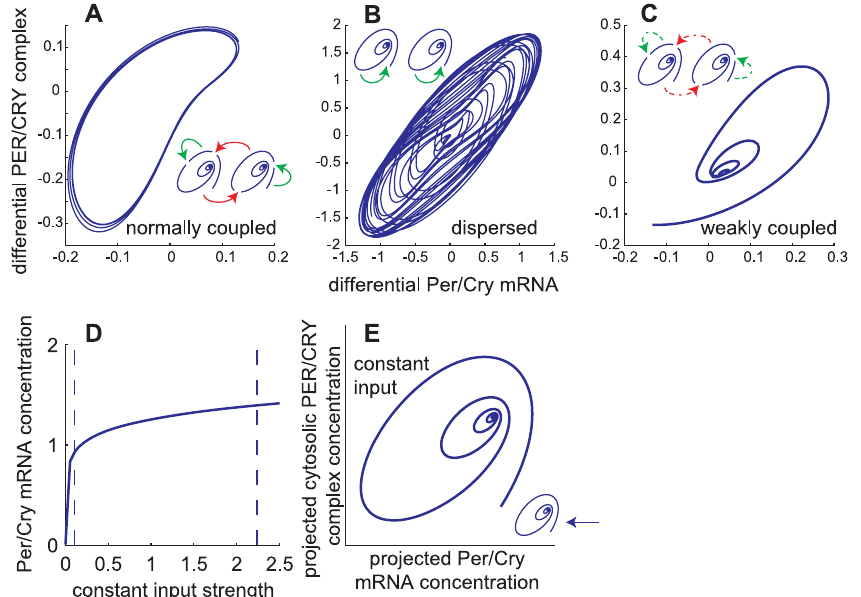
Figure 4. Single-Cell Rhythmicity Implies Synchrony (A–C) Phase space of a network of two oscillators showing possible dynamic behaviors. Each panel represents a condition that was simulated in the previous subsection. The inlets show what kind of coupling was considered (spirals, damped oscillators; solid arrows, normal coupling [ K ¼ 0.9]; dashed arrows, weak coupling [ K ¼ 0.3]; red and green arrows, paracrine and autocrine coupling, respectively). The axes show the differences of Per/Cry mRNA and PER/CRY complex concentrations between the two oscillators. This way, two oscillators can be represented in a 2-D space. (A) Normal, wild-type condition. The oscillators are normally coupled (autocrine and paracrine coupling), and the result is a regular, clock-like cycle denoting synchrony. (B) Dispersed condition. Oscillators with autocrine activation only are rhythmic, but quickly run out of phase. The result is an irregular cycle as phase differences are not constant. (C) Weak coupling. Oscillators with weak paracrine and autocrine coupling damp out to a steady state. (D) Stable steady state of Per/Cry mRNA under constant input. The minimal and maximal values of rhythmic input signals (variable X 2 ) under normal coupling conditions are indicated by the dashed lines. (E) Phase space of a single oscillator with constant input. Because the intracellular oscillator is 7-D, we had to reduce the phase space from seven to two dimensions, and we chose a projection plane for which the trajectory was closest to a spiral.